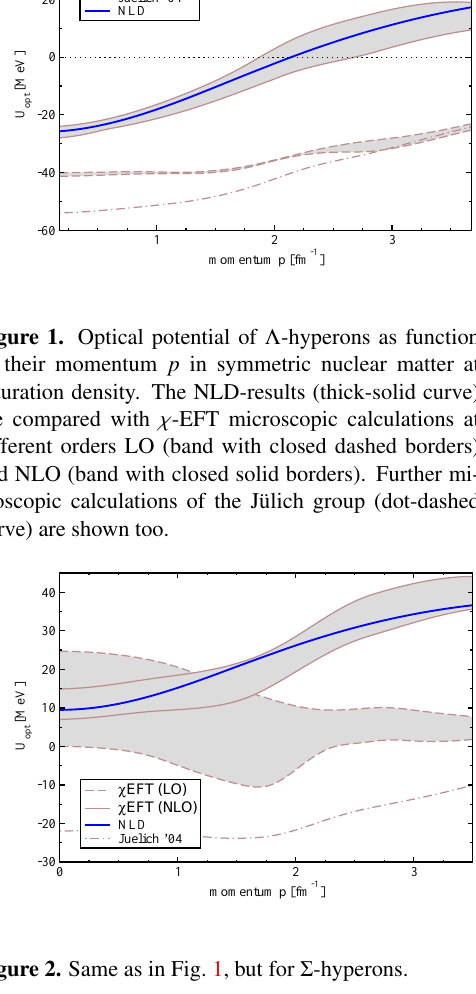
Figure 2. Same as in Fig. 1, but for Σ -hyperons.